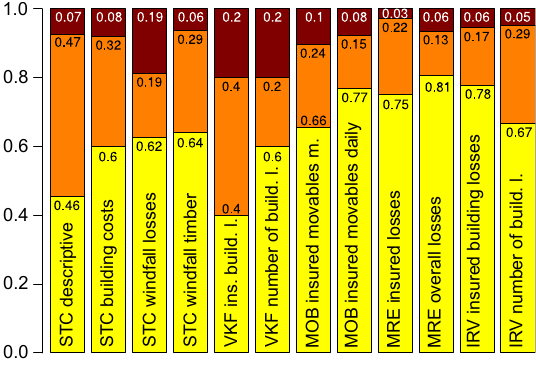
Figure 2. Proportion of moderate (yellow), severe (orange), and extreme (red) windstorm severity classes per partial series (refer Sect. 2 or Fig. 3 for abbreviations). In the labeling of the dia- gram, “ins.”, “build.”, “l.” and “m.” stand for “insured”, “building”, “losses” and “monthly”,